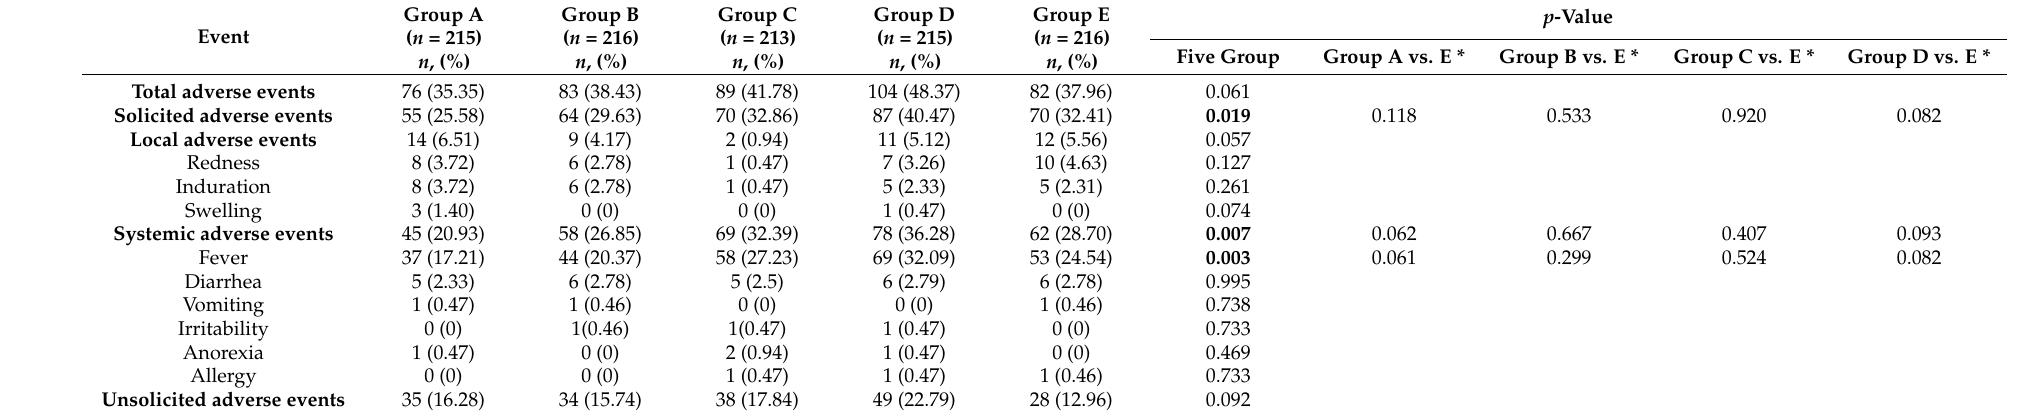
Table 4. Reported adverse events after any